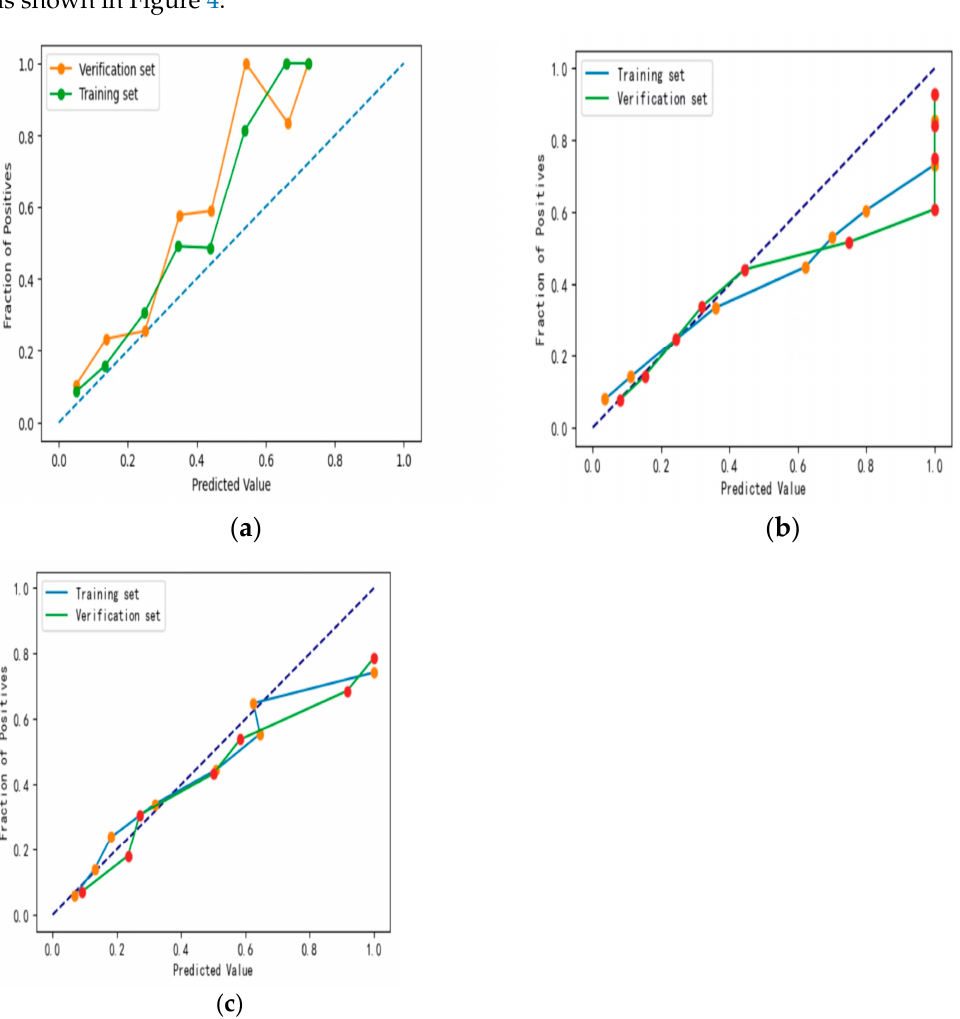
Figure 3. ROC curves of three models. ( a ) Training set; ( b ) validation set.